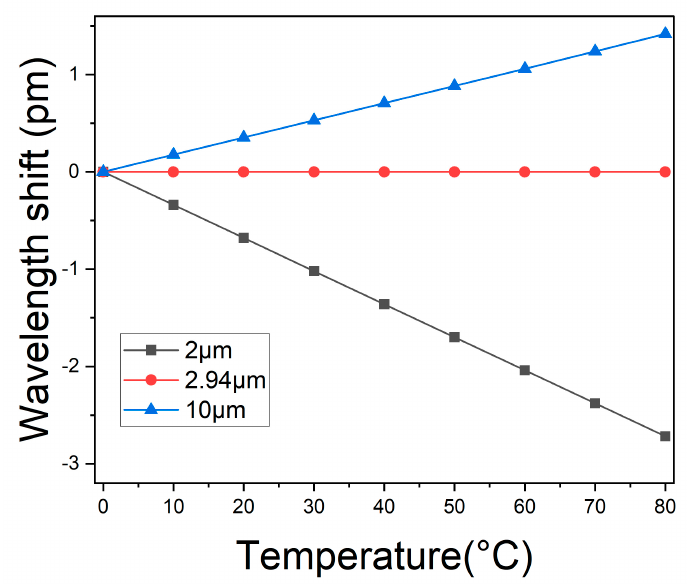
Figure 4. Spectrum shift of the sensor from 0 °C to 80 °C with different MF-BG diameters.